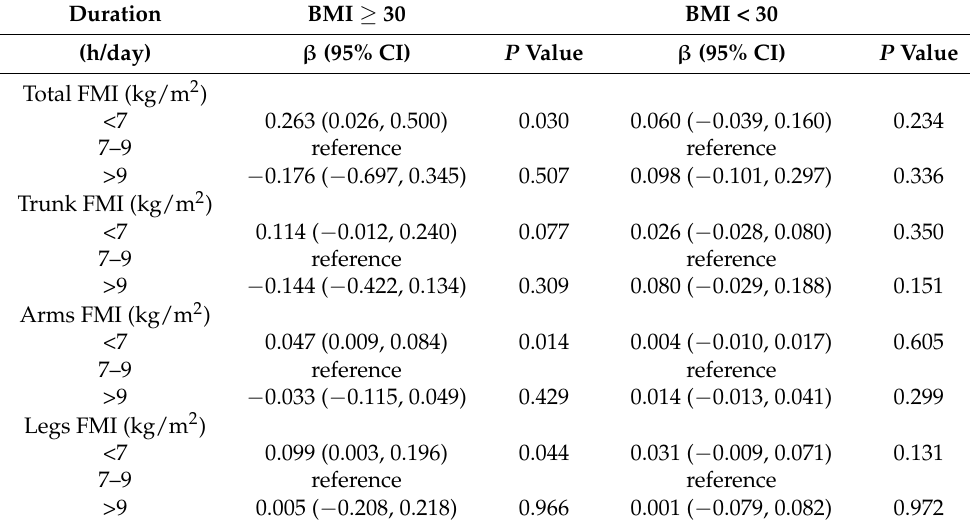
Table 4. Association between different regional fat mass and sleep duration groups in obese